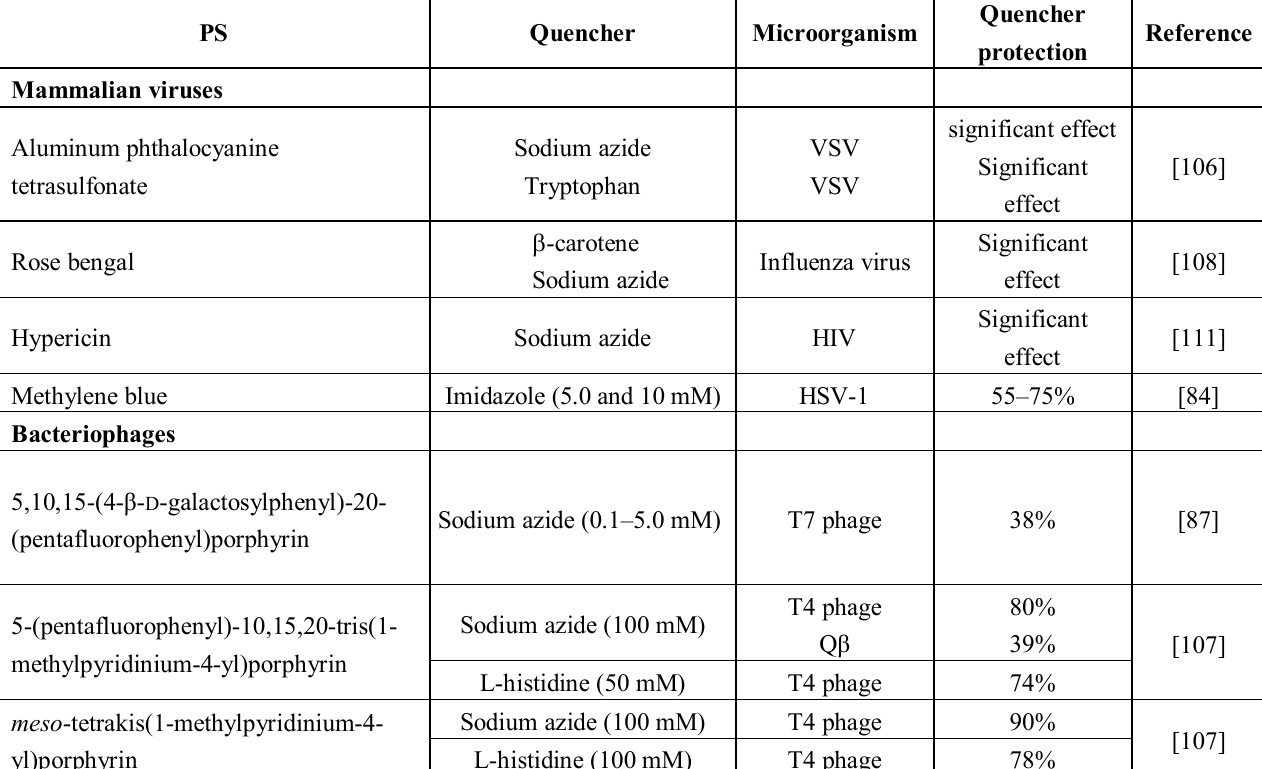
Table 3. Singlet oxygen quenchers used on mammalian viruses and bacteriophage